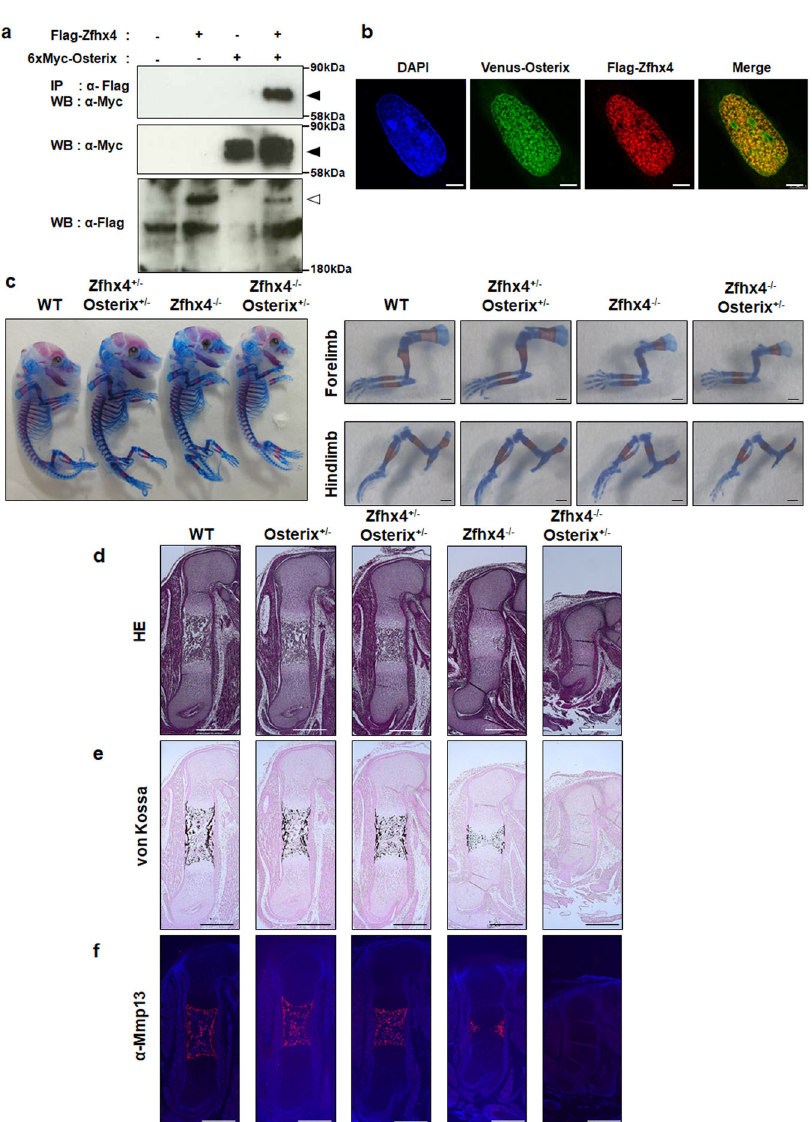
Fig. 3 Importance of the interaction between Zfhx4 and Osterix for late-stage endochondral ossi fi cation. a Physical interaction of Zfhx4 with Osterix. Coimmunoprecipitation analysis of lysates of 293FT cells transfected with Flag-Zfhx4, 6xMyc-Osterix, or both is shown. Closed arrows: 6xMyc-Osterix, Open arrow: Flag-Zfhx4 (IP immunoprecipitation, WB western blotting). b Colocalization of Flag-Zfhx4 (red) with Venus-Osterix(green) in SW1353 cells. Scale bar = 5 μ m. c Skeletal preparations of whole bodies, forelimbs, and hindlimbs of E16.5 wild-type (WT), Zfhx4 + / − ; Osterix + / − , Zfhx4 − / − , and Zfhx4 − / − ; Osterix + / − littermates stained with Alcian blue and alizarin red. Scale bar = 1 mm. Right panels show higher magni fi cation images of the forelimbs and hindlimbs shown in the left panel. d – f Paraf fi n-embedded sections of E16.5 WT, Osterix + / − , Zfhx4 + / − ; Osterix + / − , Zfhx4 − / − , and Zfhx4 − / − ; Osterix + / − littermates subjected to hematoxylin and eosin (HE) staining ( d ), von Kossa staining ( e ), and immuno fl uorescence staining with an anti-Mmp13 antibody ( f ). Scale bar = 500 μ